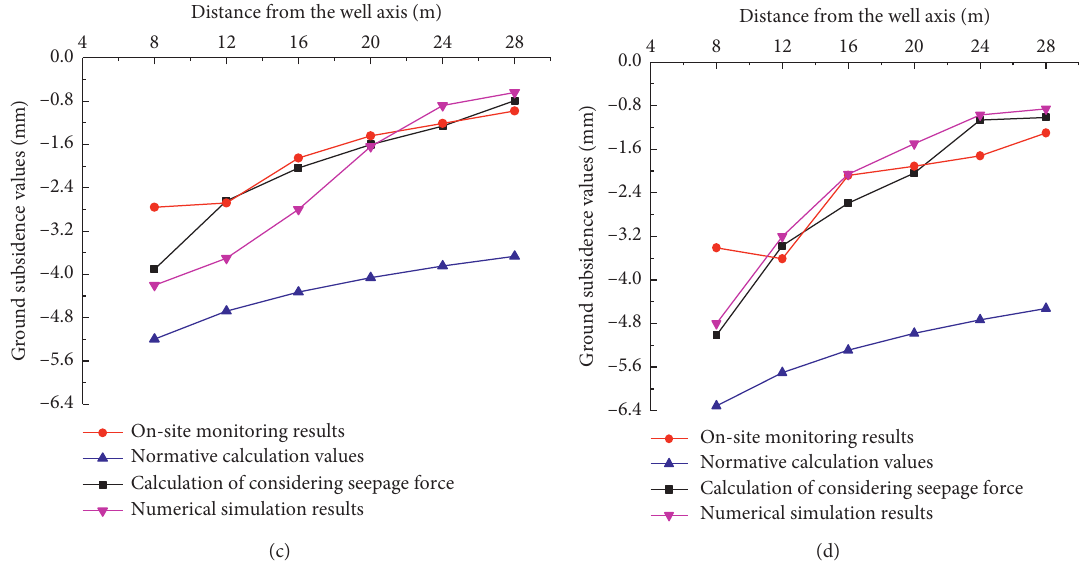
Figure 34: Comparison of settlements at different distances from well axis under different drawdowns. (a) Grade I drawdown. (b) Grade II drawdown. (c) Grade III drawdown. (d) Grade IV drawdown (drawdown becomes stable).